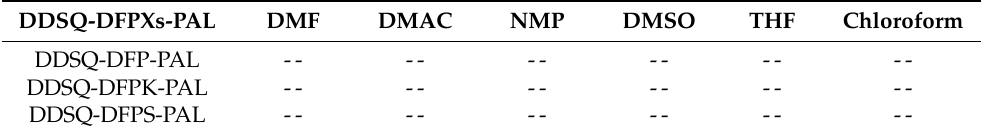
Table 3. Solubility of DDSQ-DFPXs-PAL a after